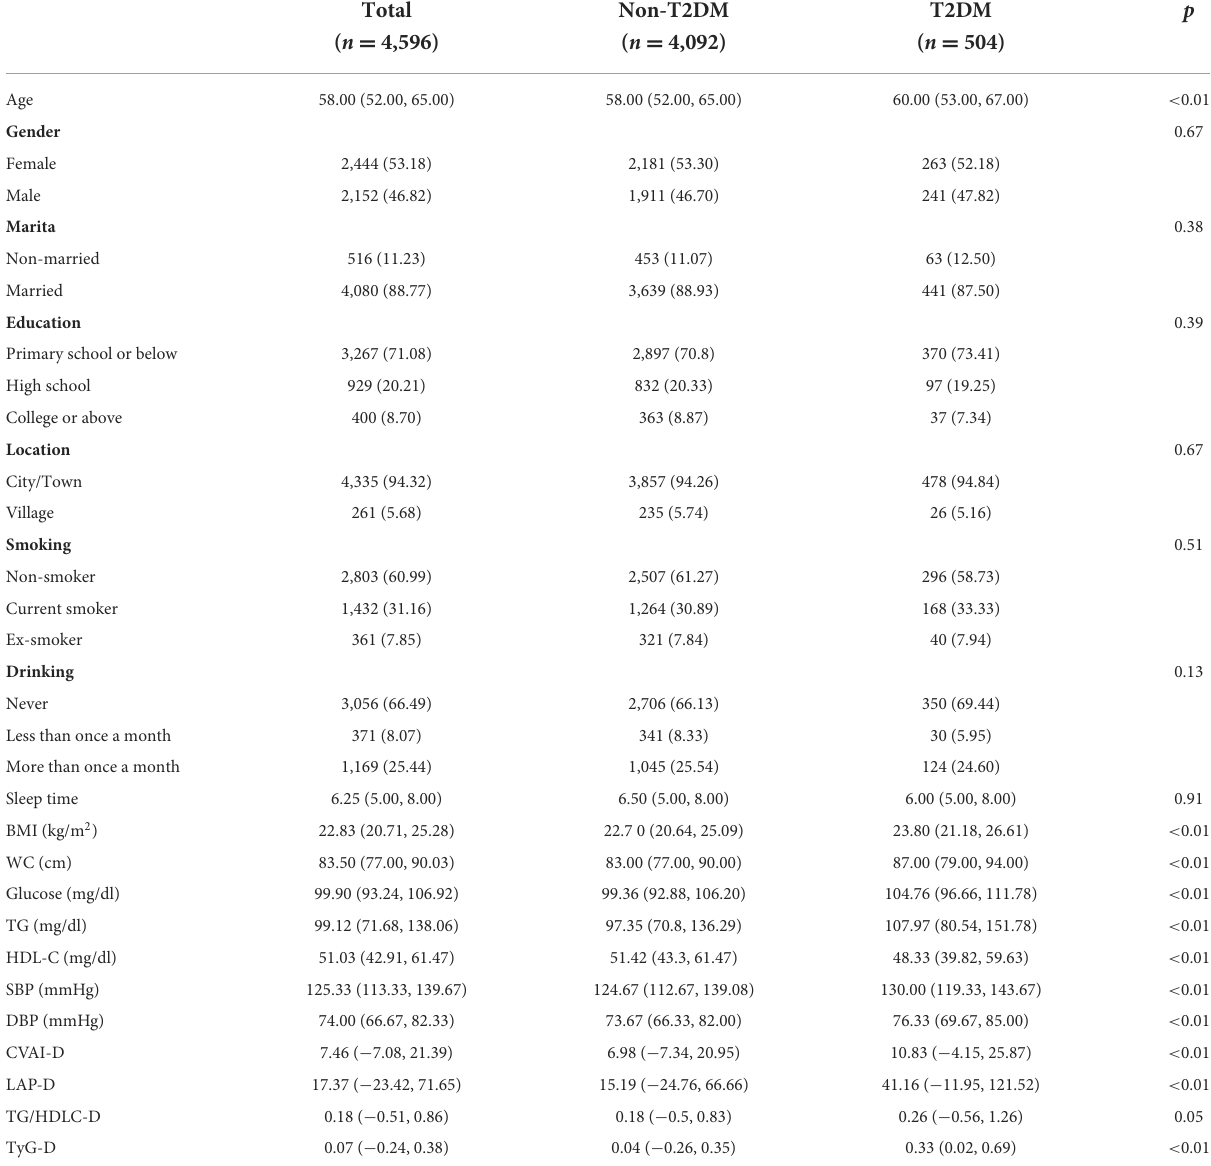
TABLE 1 The characteristics of the study participants grouped by T2DM at baseline ( N =